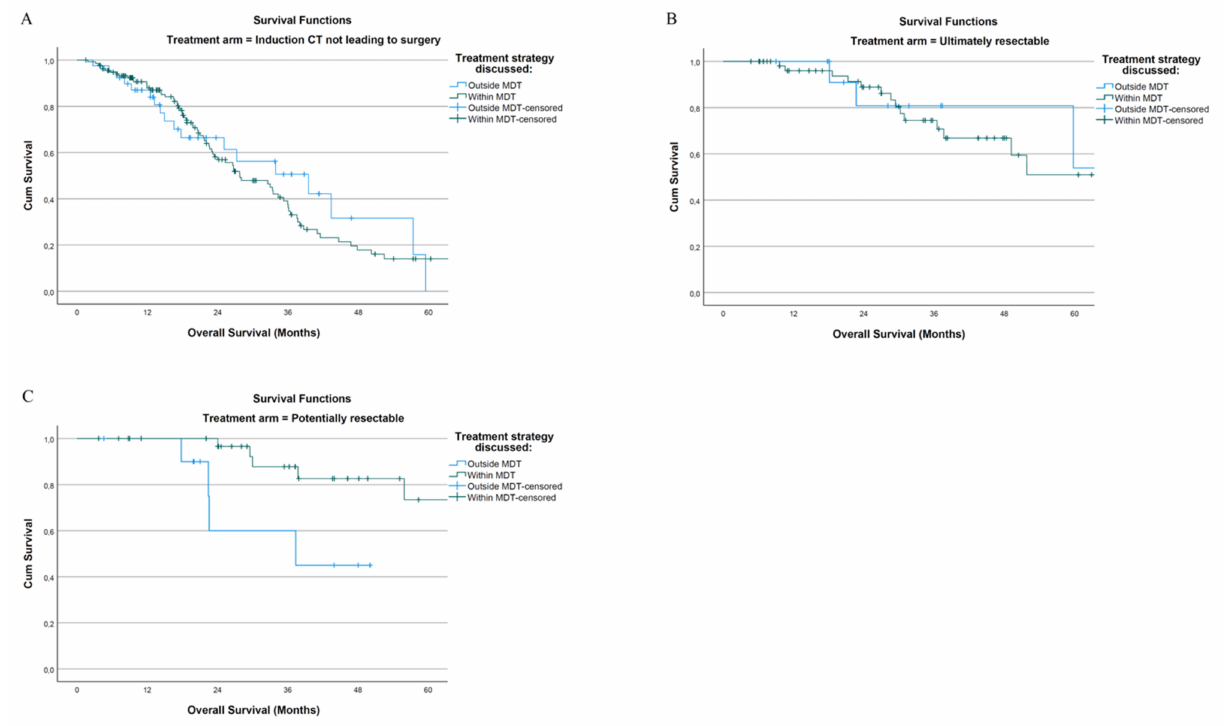
Figure 3. Kaplan–Meier curves of patients discussed or not in MDT—5-year OS of ( A ) unresected patients; ( B ) ultimately resectable patients; ( C ) potentially resectable